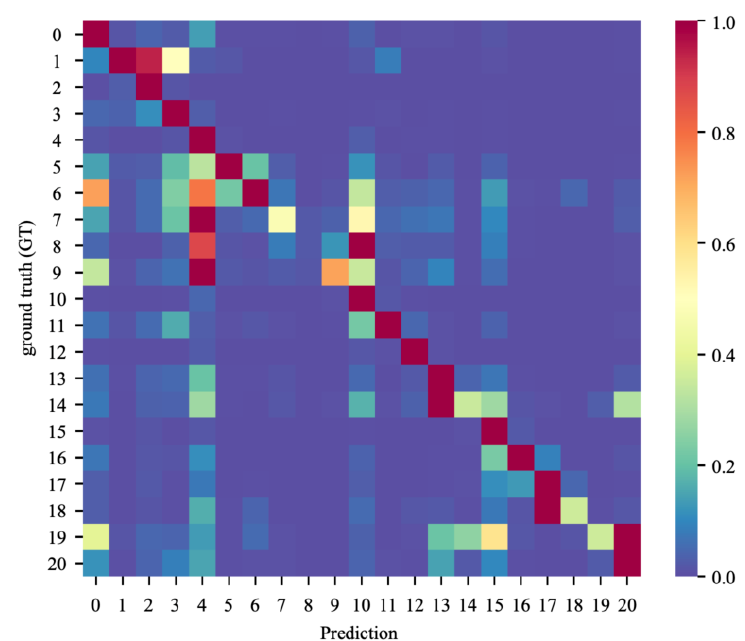
Figure 15. Confusion matrix for Cityscapes test subset images.